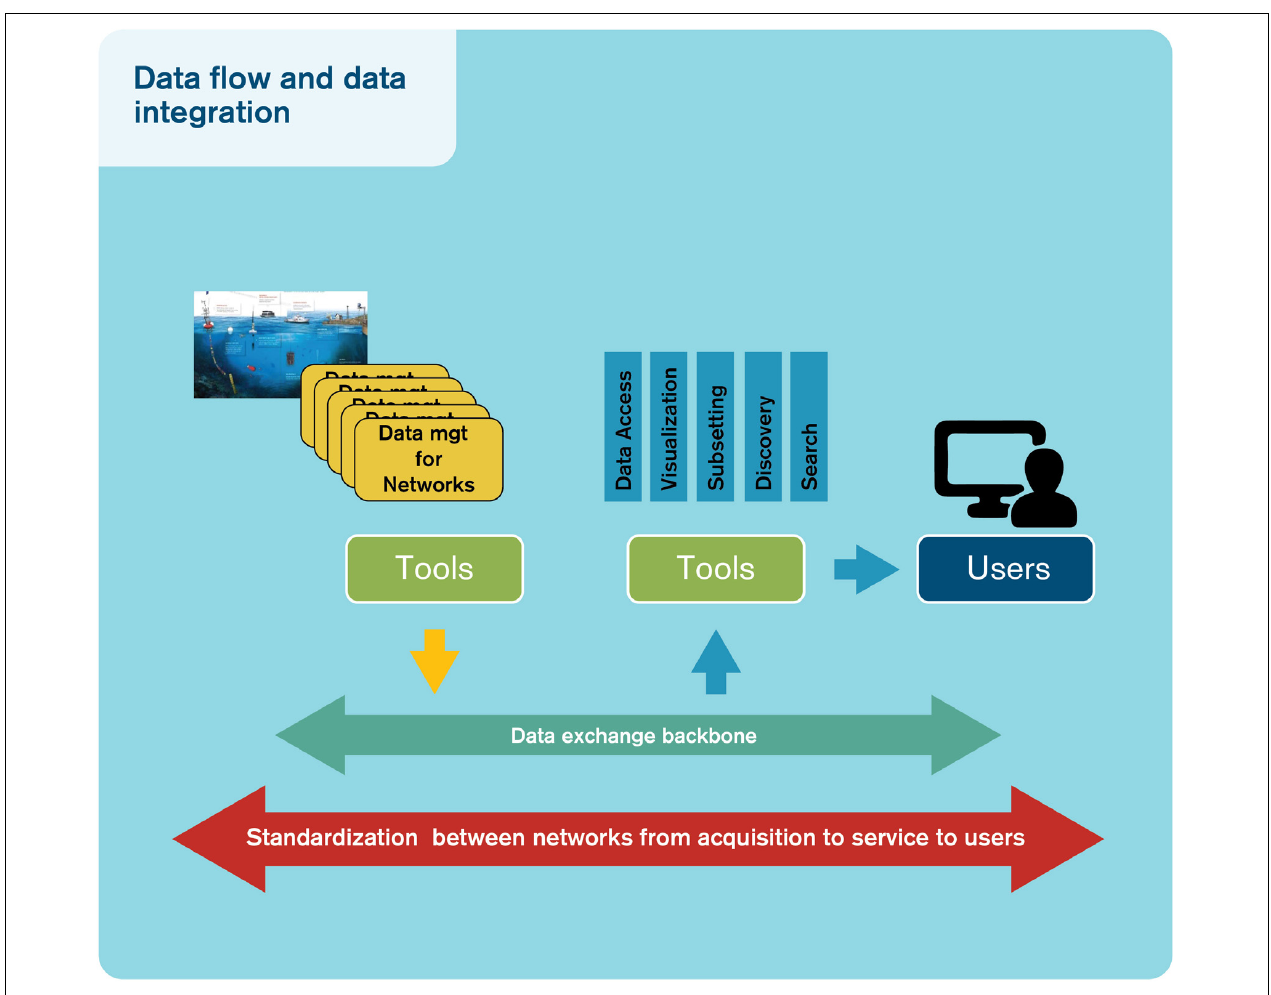
FIGURE 7 | Data flow and data integration. Schematics of the target ocean data flow from observations to users (in yellow: observing network data systems; in blue: integrators; in green and red: harmonization and integration elements). Source: